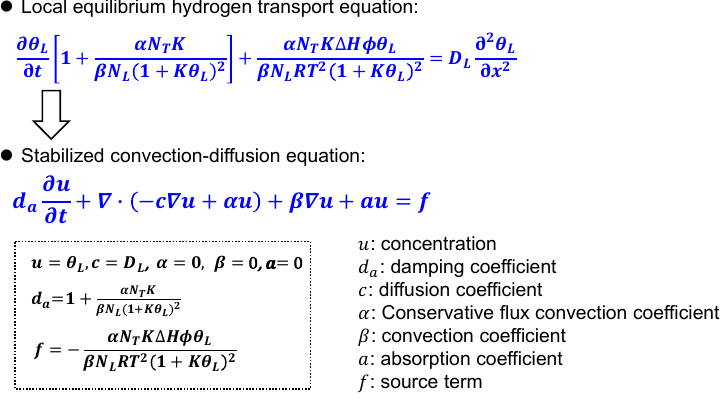
Figure 1. Analogy of the hydrogen transport equation to the stabilized convection–diffusion equation in COMSOL software.